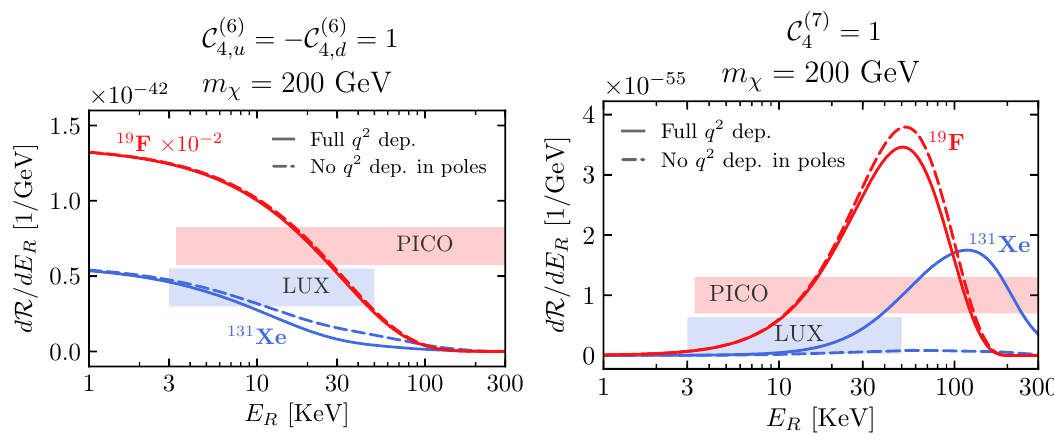
Figure 5 . The di(cid:11)erential event rate, d on Xenon (blue) and Fluorine (red) for both panels, the solid curves include the full q 2 dependence in the form factor F ~ dashed lines include only the zero recoil limit, F ~ ranges of experimental sensitivity for the LUX (blue) and PICO (red)